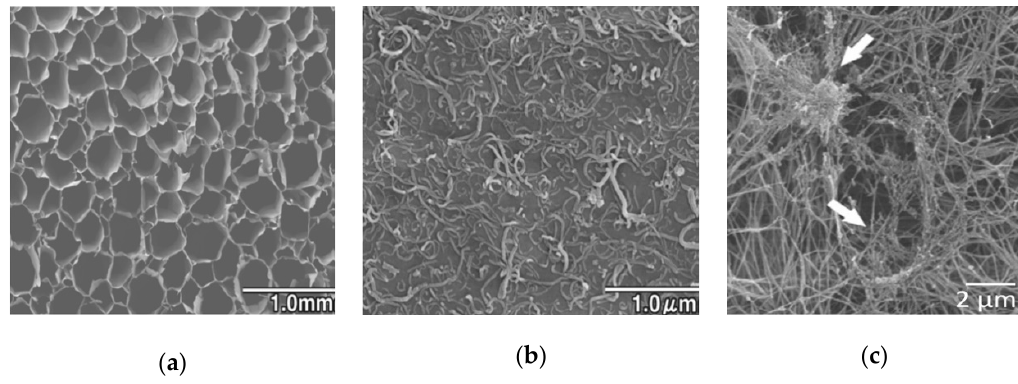
Figure 3. ( a ) SEM image of multi-walled carbon nanotubes (MWCNT)-coated collagen scaffold, ( b ) SEM image of the internal pores of MWCNT-coated sponge. Fibers can be observed on the surface of MWCNTs. Reproduced with permission from [87] Elsevier, 2011. ( c ) SEM image of collagen/MWCNT composite scaffold. MWCNT aggregates were confirmed within the collagen fiber (white arrows). Reproduced with permission from [88] Elsevier, 2016.